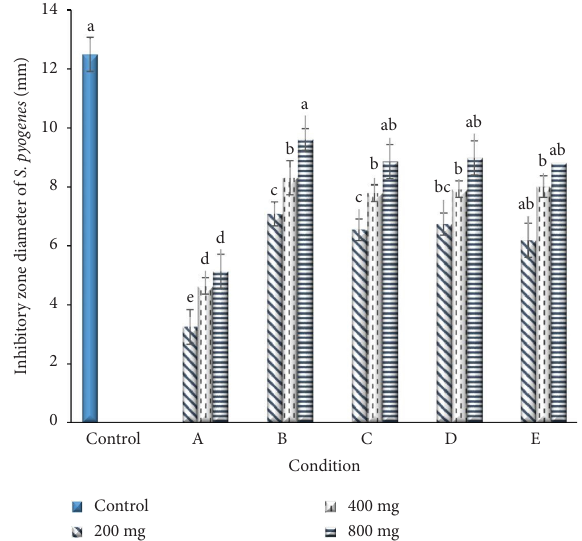
Figure 2: Growth inhibition zone of S. pyogenes in diferent conditions. Control: gentamicin, A: enzyme ratio of 30AU/kg protein, 55 ° C and 210min; B: enzyme ratio of 60AU/kg protein, 50 ° C and 150min; C: enzyme ratio of 60 AU/kg protein, 55 ° C and 180min; D: enzyme ratio of 90AU/kg protein, 50 ° C and 150min; E: enzyme ratio of 90AU/kg protein, 50 ° C for 180min and control: represented gentamicin as the control treatment.